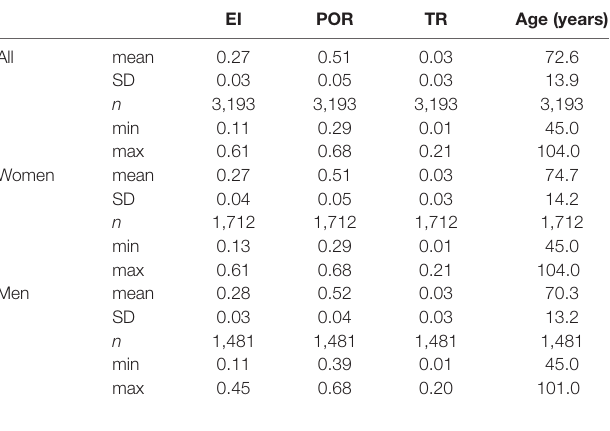
TABLE 1 | Values of neuroimaging linear measures.